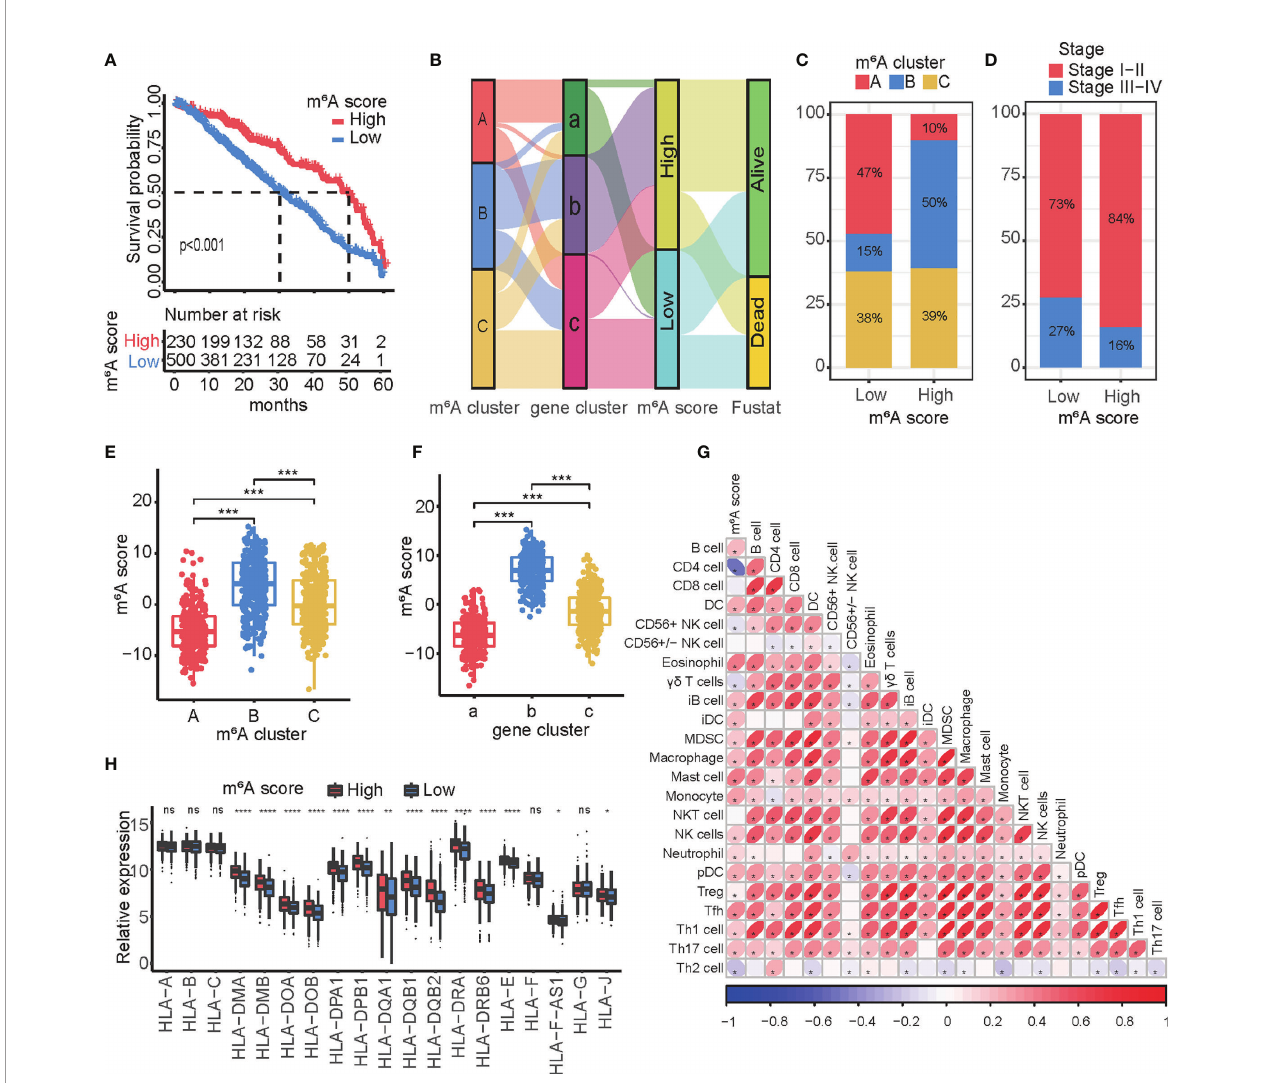
FIGURE 5 | Construction and characteristics of the m 6 A score. (A) Kaplan-Meier curves showing the differences in survival of the high ( n = 230) and low ( n = 500) m 6 A score groups in LUAD. Log-rank test, p < 0.001. (B) Changes in m 6 A clusters among groups with different gene clusters, m 6 A score, and fustat (alive, dead) are shown through an alluvial diagram. (C) The proportion of the three m 6 A modi fi cation patterns in high and low m 6 A score groups. (D) The proportion of patients with different stages in high and low m 6 A score groups. (E) Differences in the m 6 A score between the three m 6 A clusters. The asterisks represented the statistical p -value (*** p < 0.001). (F) Differences in m 6 A score between the three gene clusters. The asterisks represented the statistical p -value (*** p < 0.001). (G) Correlations between the m 6 A score and tumor-in fi ltrating immune cells using Spearman ’ s analysis. The positive and negative correlations are marked with red and blue, respectively. (H) Differences in the expression of MHC molecules between the high and low m 6 A score groups. The upper and lower ends of the boxes represented interquartile range of values. The lines in the boxes represented median value, and black dots showed outliers. The asterisks represented the statistical p value (ns p > 0.05; * p < 0.05; ** p < 0.01; **** p <